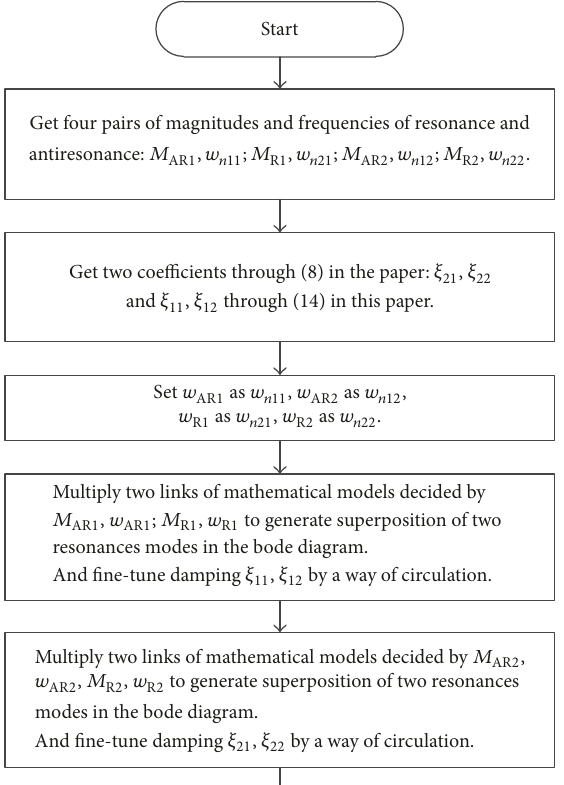
Figure 5: The flow chart for numerical simulation of two resonance modes.